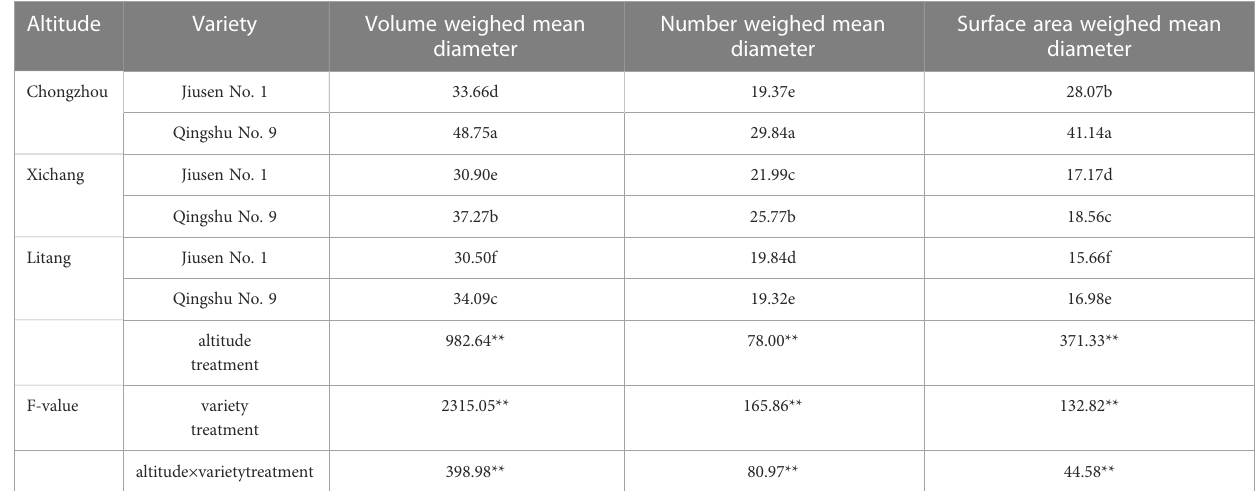
TABLE 3 Diameter distribution of potato starch granules at different altitudes. Altitude